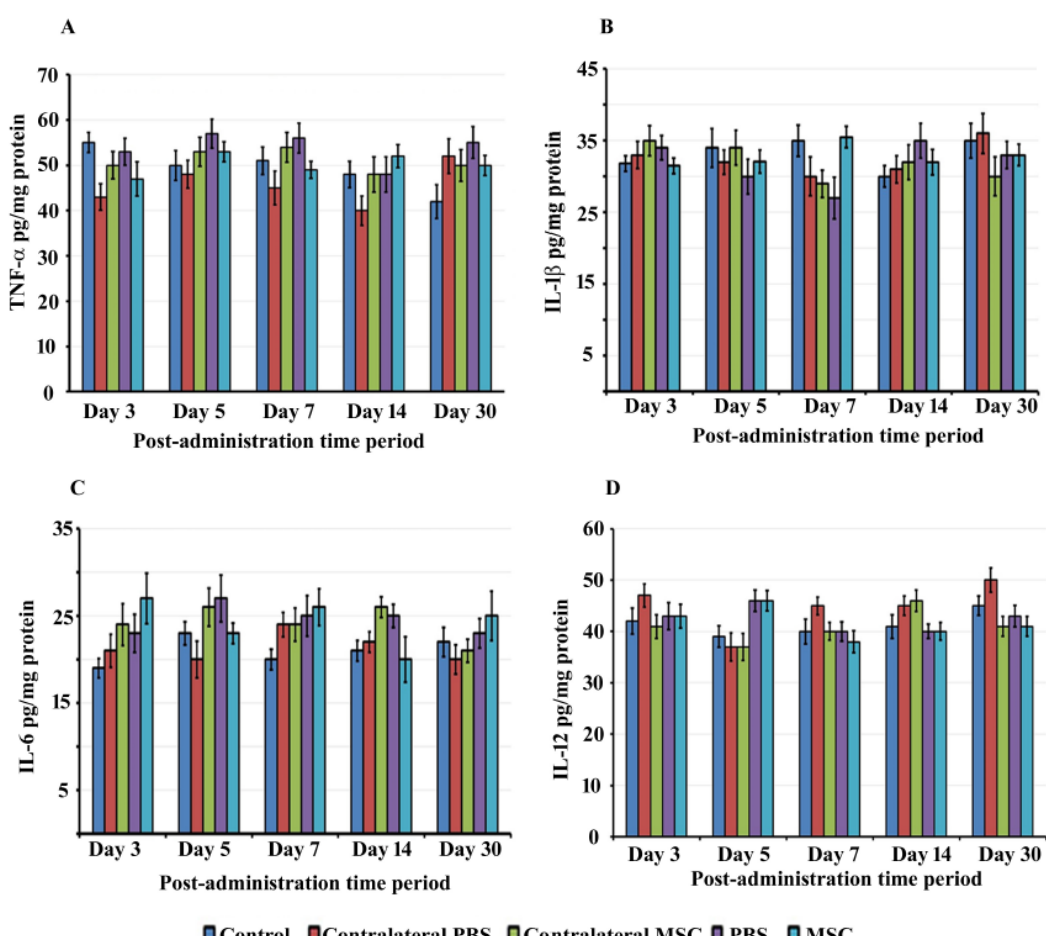
Figure 3. Proinflammatory cytokines: The levels of proinflammatory cytokines, tumor necrosis factor (TNF)- α ( A ), interleukin (IL)-1 β ( B ), IL-6 ( C ) and IL-12 ( D ) were determined in cochlear homogenates by ELISA. Data are expressed as mean values ± SD.